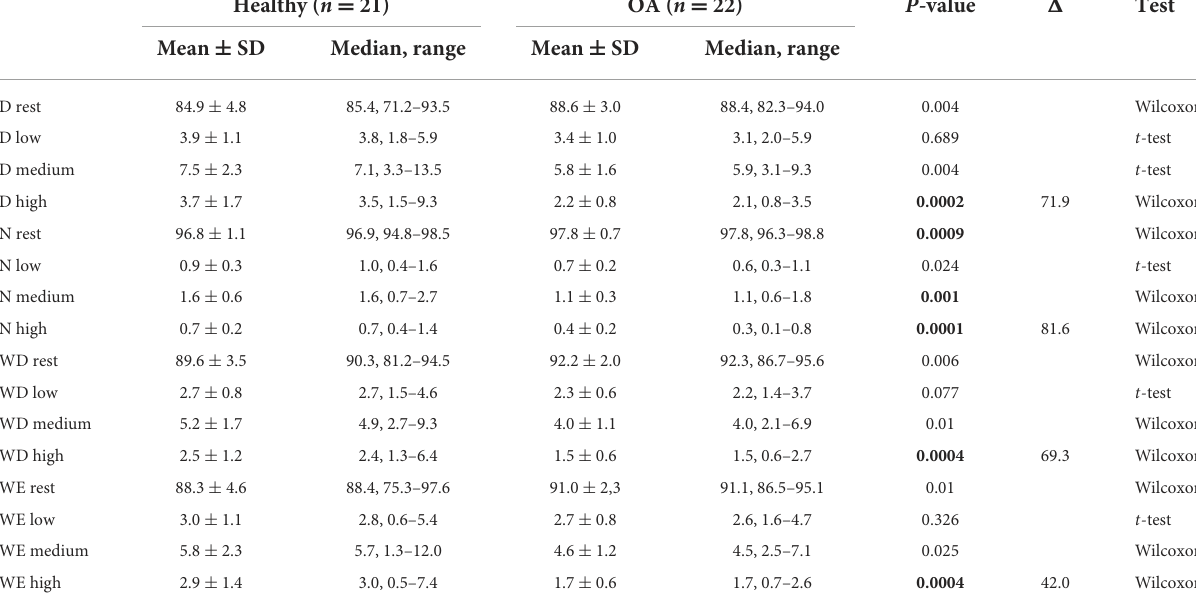
TABLE 4 Percentage of time spent in different activity levels (as defined by Petpace output) during the day, night, weekday, and weekends. Healthy ( n = 21) OA ( n =